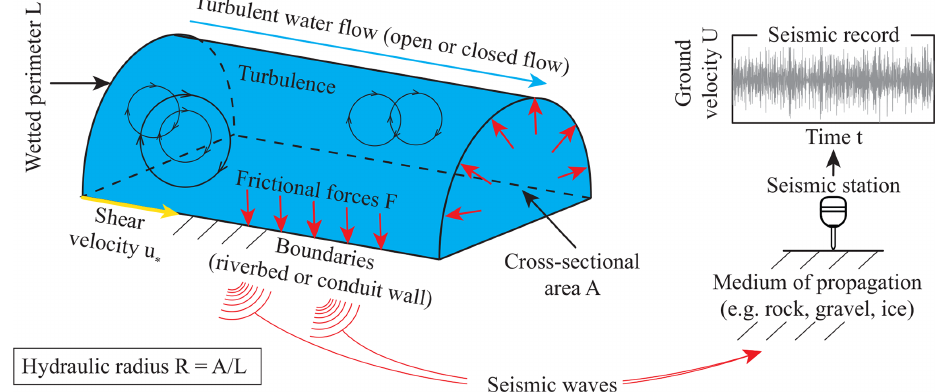
Figure 1. Schematic representation of subglacial channel-flow-induced seismic noise. Representation of an idealized conduit of hydraulic radius R with a wall shear velocity u ∗ (see Eq. 3). Turbulent flow generates frictional forces F , causing seismic waves and resulting in a ground velocity U that is recorded at a distant seismic station (see Eq.